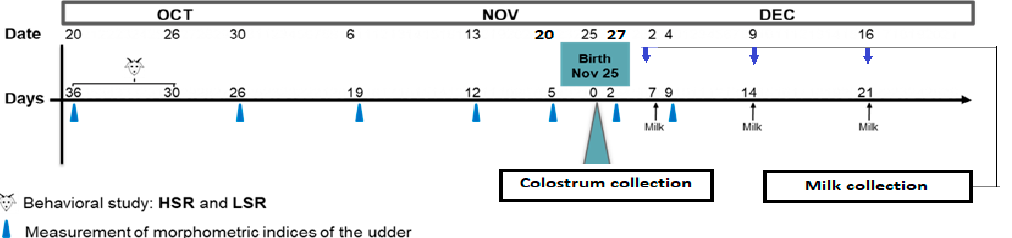
Figure 1. Timeline of actions along with the experimental period. A behavioral study was conducted in all the experimental units ( n = 15) to determine the goat social rank, either high (HSR) or low (LSR). The behavior test was carried out at feeding time (08:00, 13:00, and 17:00) for a period of 60 min (i.e., 180 min total d − 1 during 7 days). At the time of parturition and before kid suckling, a sam- ple of 20 mL of colostrum was individually collected per goat from both udders; samples were pooled to generate a homogeneous mixture; the same process was performed during the milk post- partum